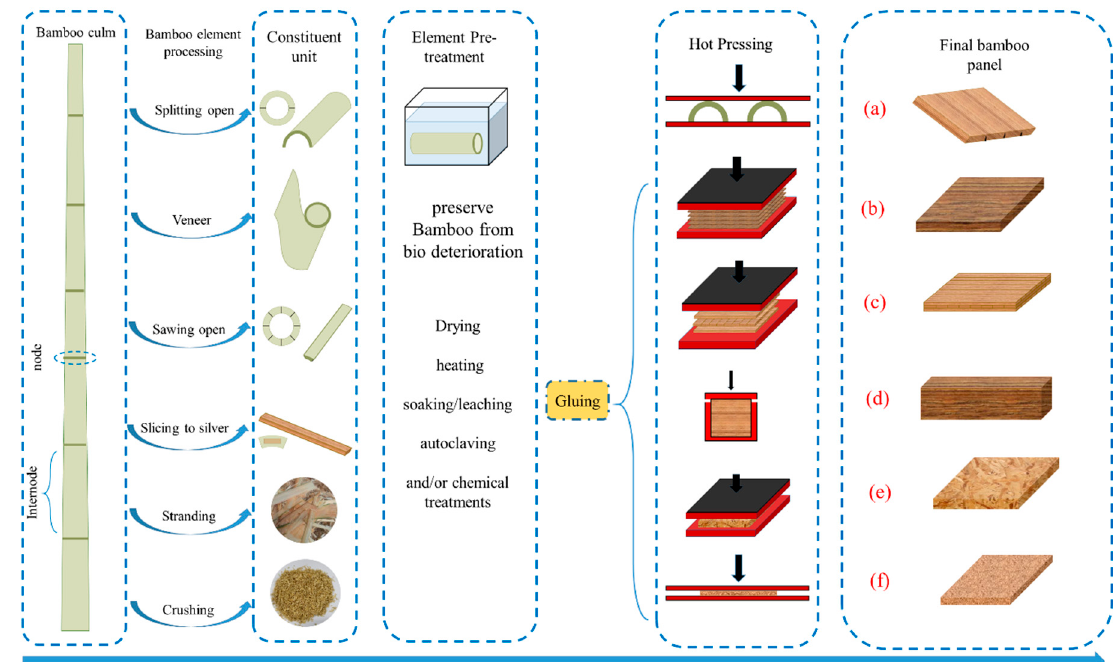
Figure 6. Summary of bamboo-based panel production processes. ( a ) Flattened bamboo panel, ( b ) Bamboo laminated lumber, ( c ) Plybamboo, ( d ) Bamboo scrimber, ( e ) Bamboo oriented strand board, ( f ) Bamboo particleboard).